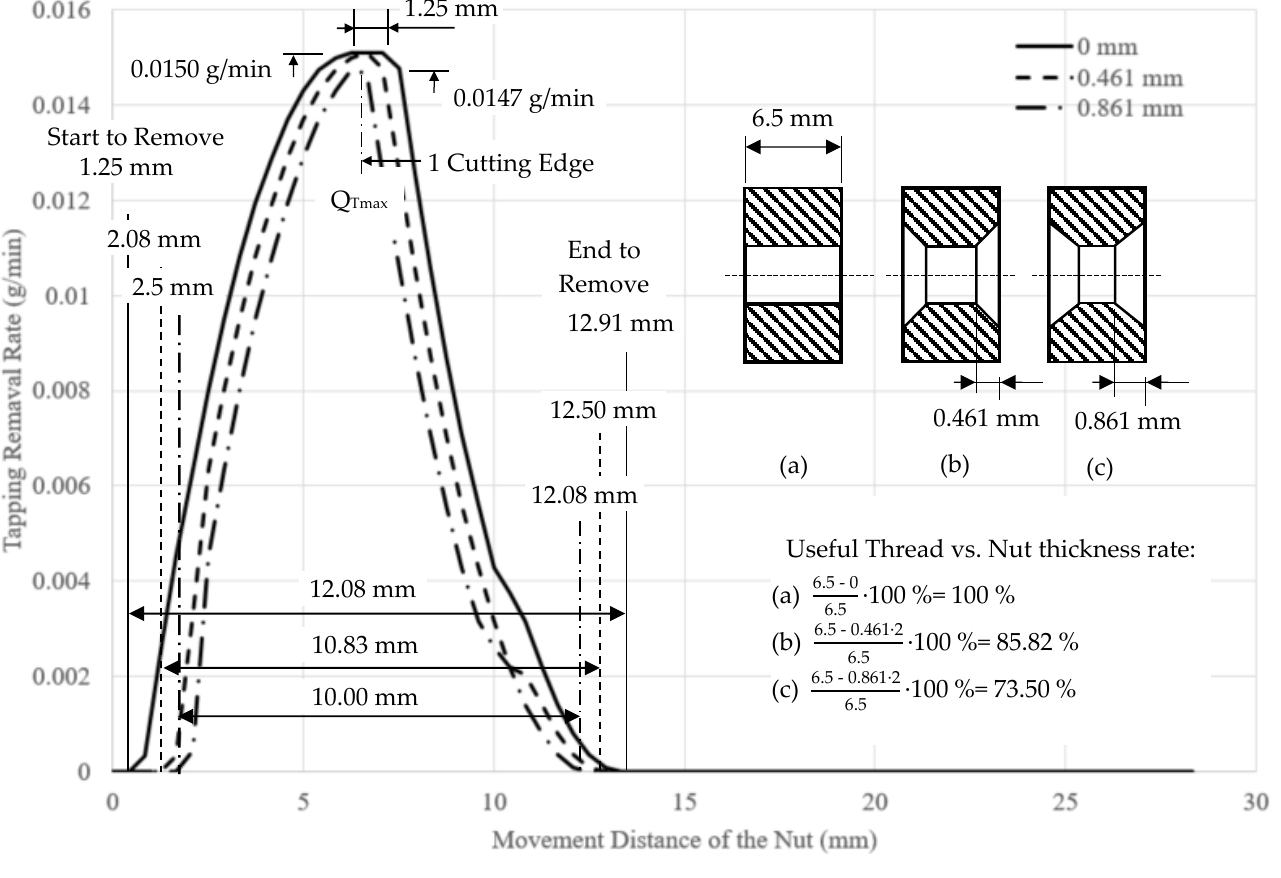
Figure 7. The tapping removal amount in different chamfer depth: ( a ) 0 mm; ( b ) 0.461 mm; ( c ) 0.861 mm.